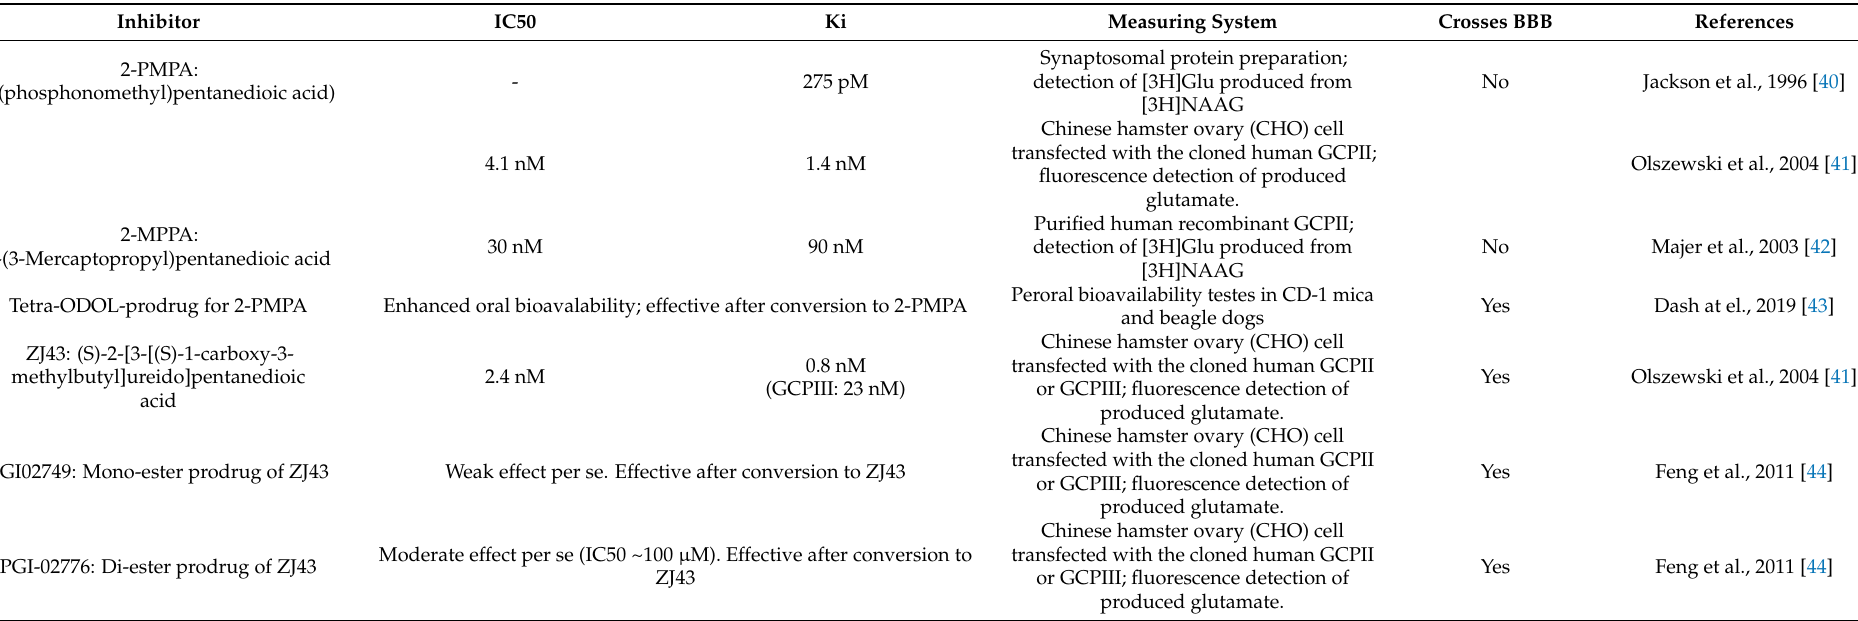
Table 1. Inhibitors of glutamate carboxypeptidase II. IC 50 , half maximum inhibitory concentration; Ki, inhibition constant; and BBB, blood–brain